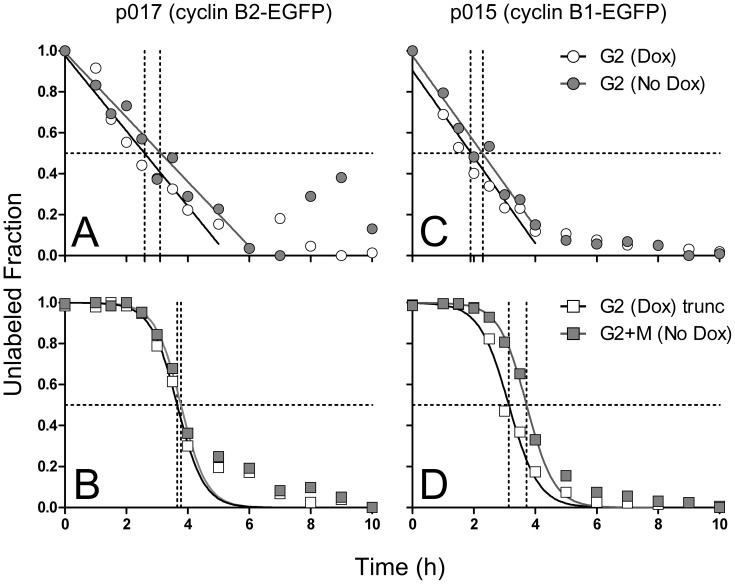
B cyclin-EGFP expression rescues the G2 arrest phenotype of B cyclin co-depletion.Cyclin B2-EGFP conditional expressing p017-4 cells (A,B) and cyclin B1 p015-4 cells (C,D) were transfected with control siRNA and cultured in the presence of Dox (white symbols) or transfected with both B cyclin siRNAs and cultured without Dox (gray symbols). Cells were continuously labeled with BrdU, and at timed intervals, fixed and stained for cell cycle analysis. A, C: Decay curves of the unlabeled G2 fractions. B, D: Decay curves of the unlabeled G2+M fraction. The experiment was performed in duplicate; the mean values are plotted. Regressions were performed on samples from time 0–4 hours.